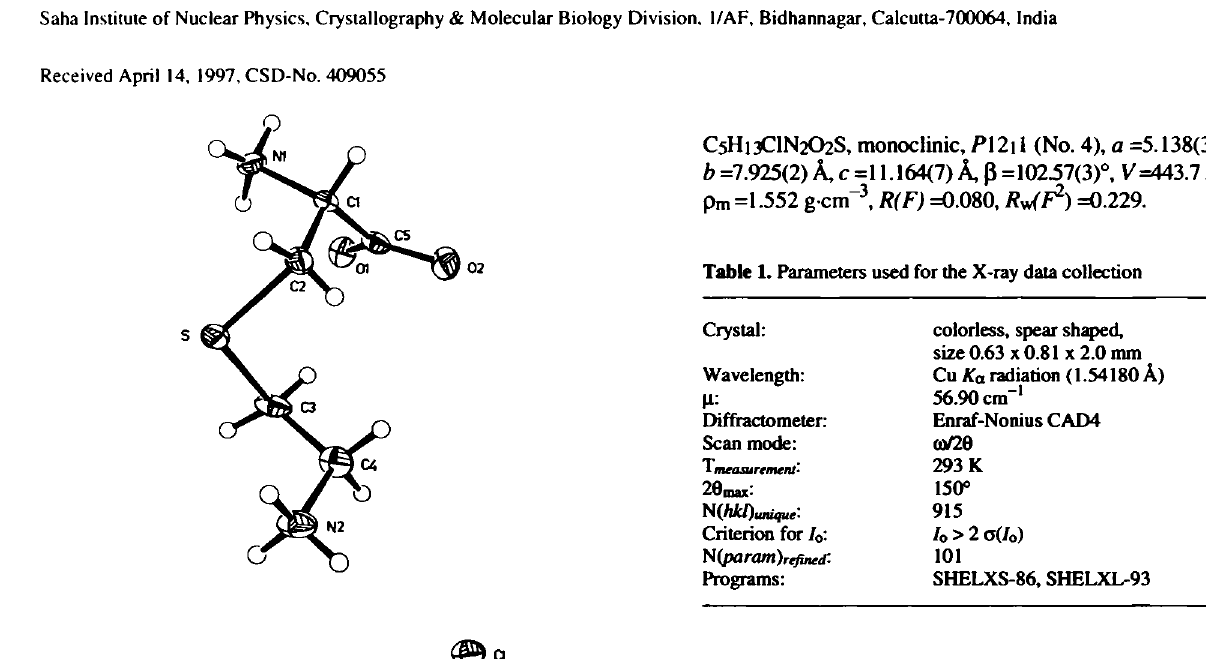
Table 2. Final atomic coordinates and displacement parameters (in